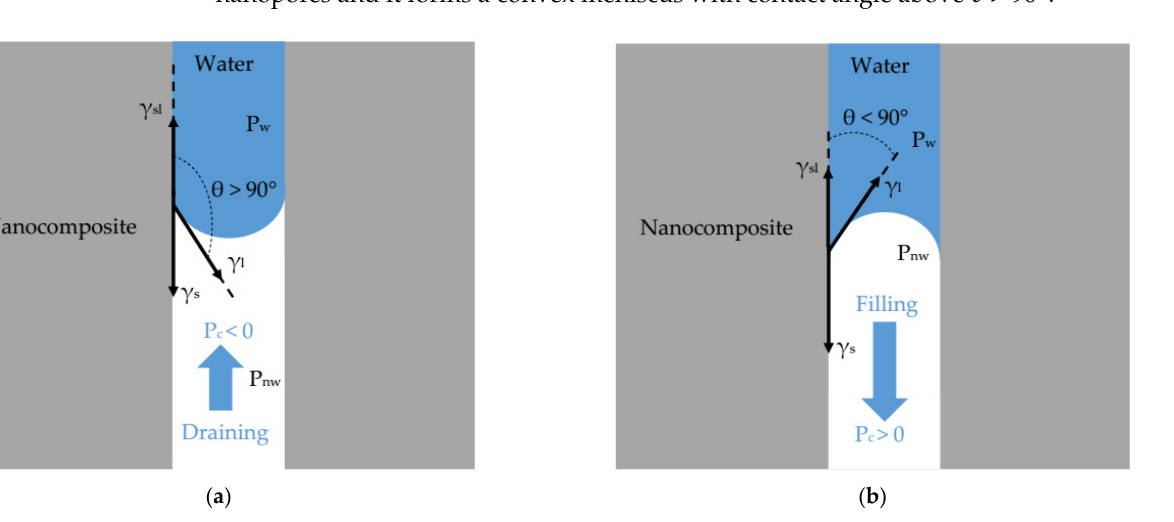
Figure 2. Capillary pressure action in nanopore r p << λ c ( a ) capillary filling with hydrophilic nanocomposite ( b ) capillary draining with hydrophobic nanocomposite.